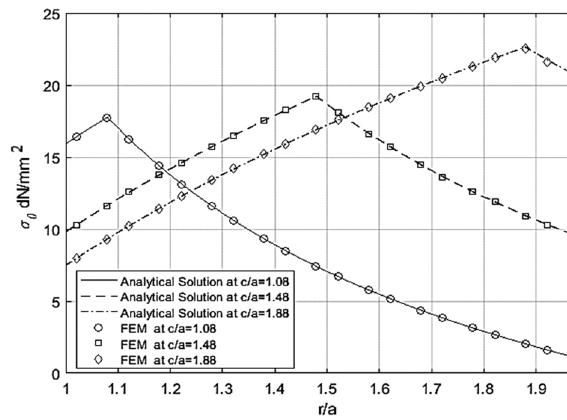
Figure 4: Variation of dimensionless radial displacement during the elastic – plastic expansion.